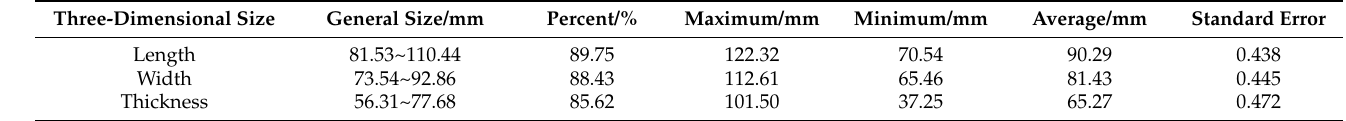
Table 1. Three-axis dimensions of lily